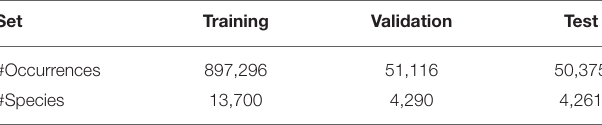
TABLE 1 | Summary table of the number of occurrences and species in the training, validation, and test sets.